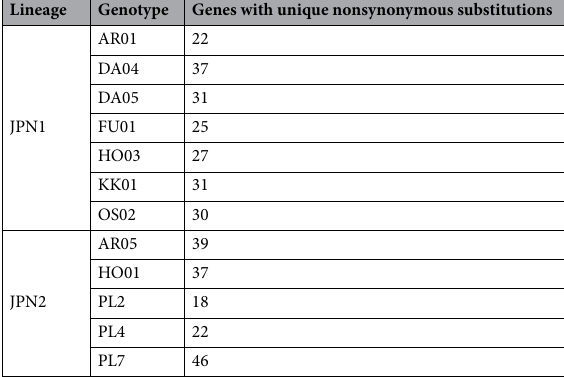
Table 1. The number of genes with unique nonsynonymous substitutions in each genotype.